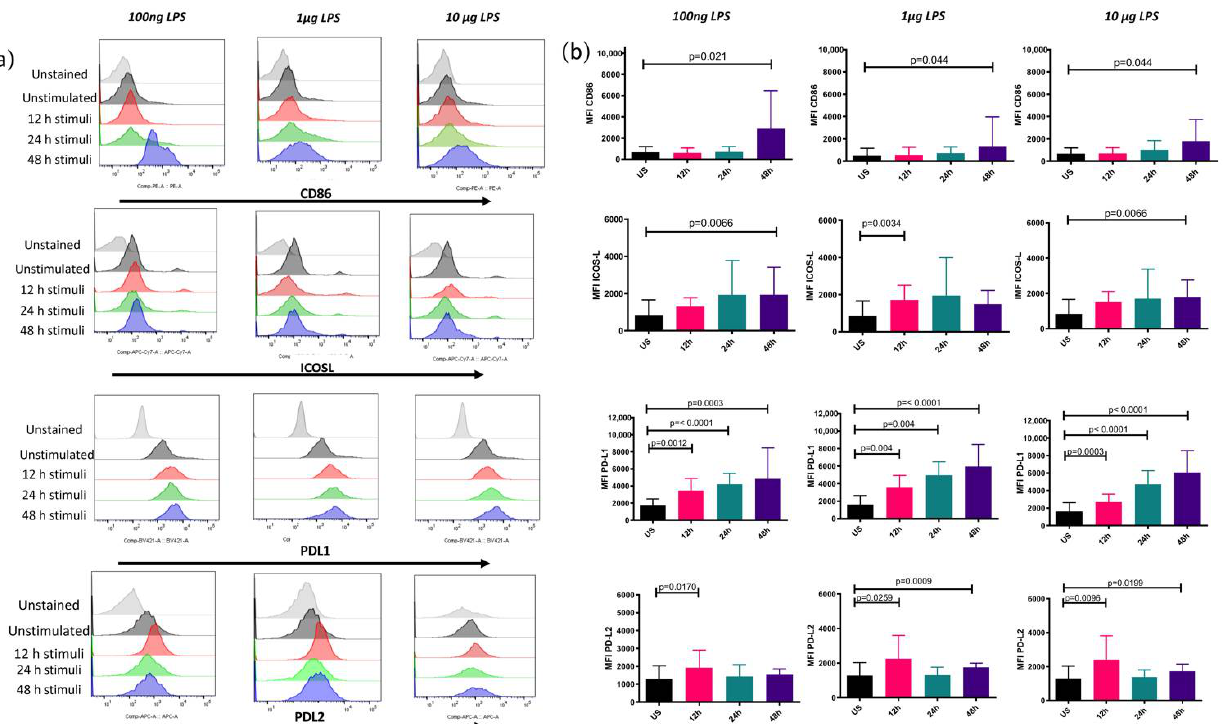
Figure 1. Costimulatory molecules show a differential kinetic expression. Mean fluorescence intensity for CD86, ICOS-L, PDL1, and PDL2 on Mo-DCs. Mo-DCs from healthy donors were stimulated for 12, 24, or 48 h with 100 ng, 1 µg, or 10 µg of LPS or left unstimulated (US). Cells were stained with fluorochrome-conjugated antibodies, as described in the materials and methods. ( a ) Representative histogram for each costimulatory molecule in the different experimental conditions evaluated. ( b ) The data shown represent the mean ± SD of MFI for 3 independent assays performed in triplicate.